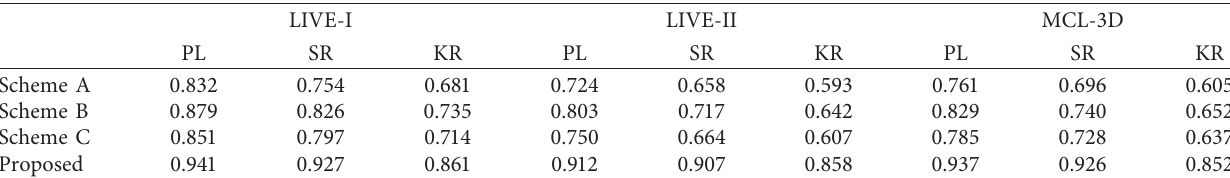
Table 5: Performance of each component in the proposed